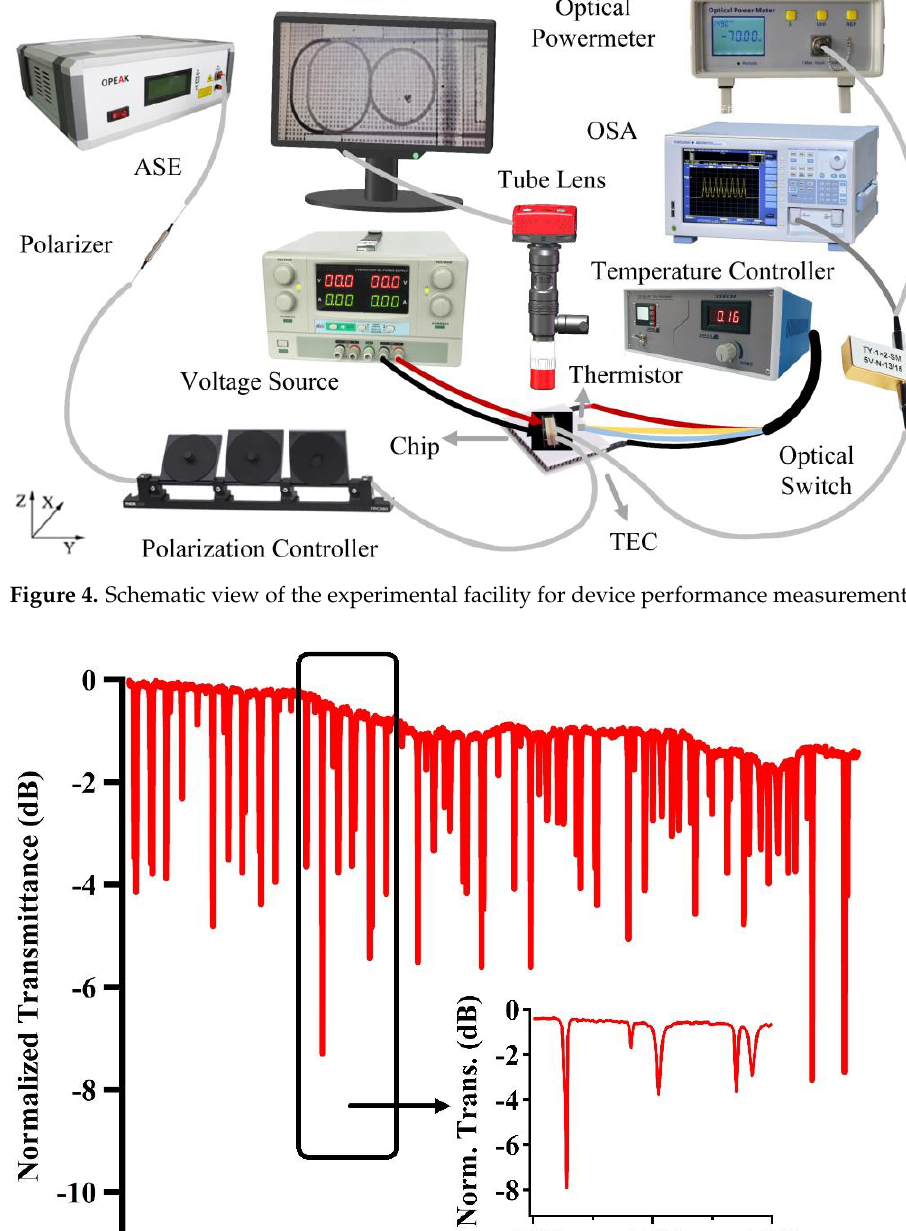
Figure 6. ( a ) Response spectra with changing voltage imposed on the microheater above U-shaped path. ( b ) The corresponding resonance wavelength and extinction ratio variation with the imposed voltage. 4. Optical Bistability Generation To effectively generate the optical bistability state on the fabricated chip, we used a pump at a wavelength of 1548.86 nm, slightly different from the resonance wavelength for the obvious observation of the influence of input light intensity on the resonance per- formance [31]. For the experimental setup, the ASE light source in Figure 4 was replaced with a tunable laser and erbium doped fiber amplifier. The output optical power was measured with the change in the input power. Detailed measured results are displayed in